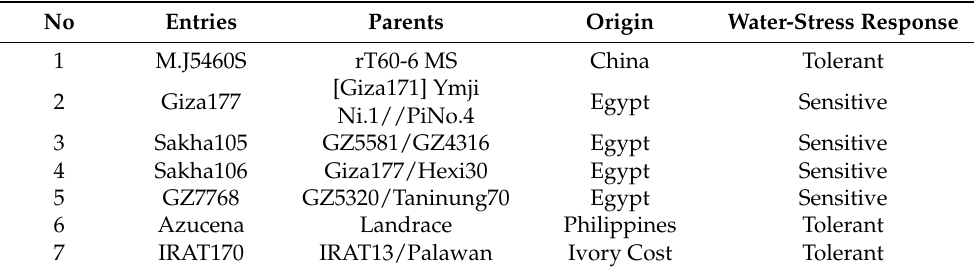
Table 5. Rice parental genotypes, parentage and